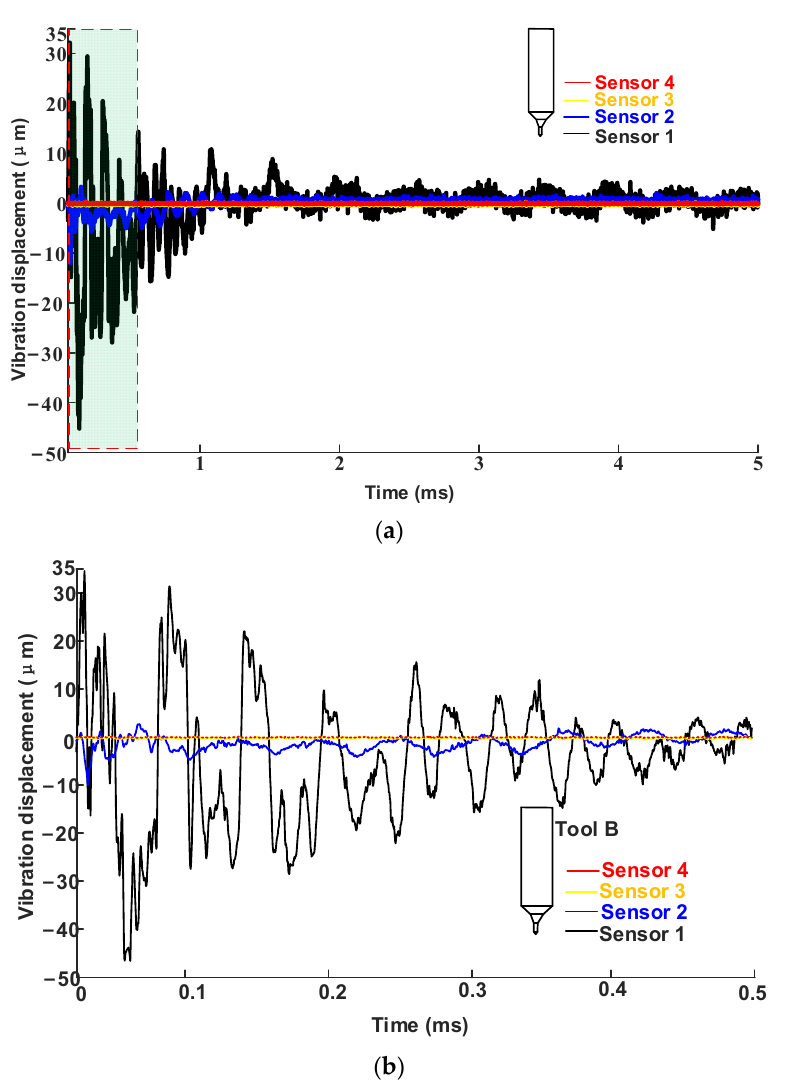
Figure 14. Impact response of Tool B at different positions. ( a ) raw data and ( b ) de-noised data (for clearer expression, only the first 0.5 ms is given